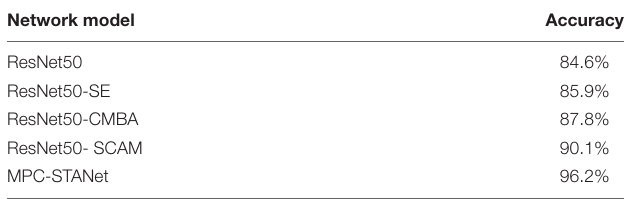
TABLE 2 | The recognition accuracy of the original dataset and the preprocessed dataset in the three models.